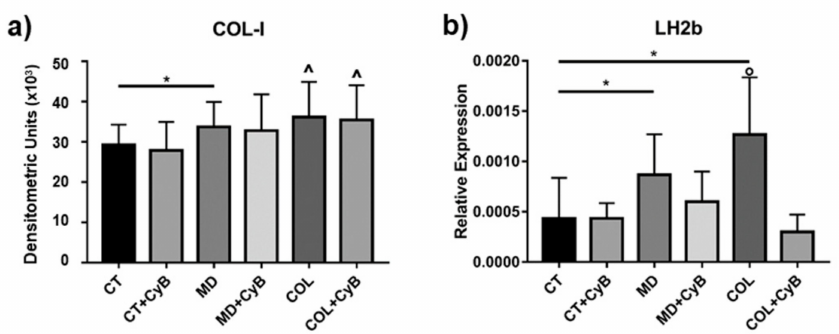
Figure 6. ( a ) Bar graphs showing COL-I protein levels obtained using slot blot after densitometric scanning of immunoreactive bands in the considered experimental conditions. Data are expressed as mean ± SD. ( b ) mRNA levels for Long lysyl hydroxylase 2 (LH2b) in CT and tenocytes cultured on MD and COL with or without CyB treatment assessed by real-time PCR. Data were normalized on GAPDH gene expression and are expressed as mean ± SD for at least two independent experiments. * p < 0.05 using t -test. ˆ p < 0.05 vs. CT, CT + CyB, COL + CyB vs. CT + CyB; ◦ p < 0.05 vs. CT and COL + CyB using